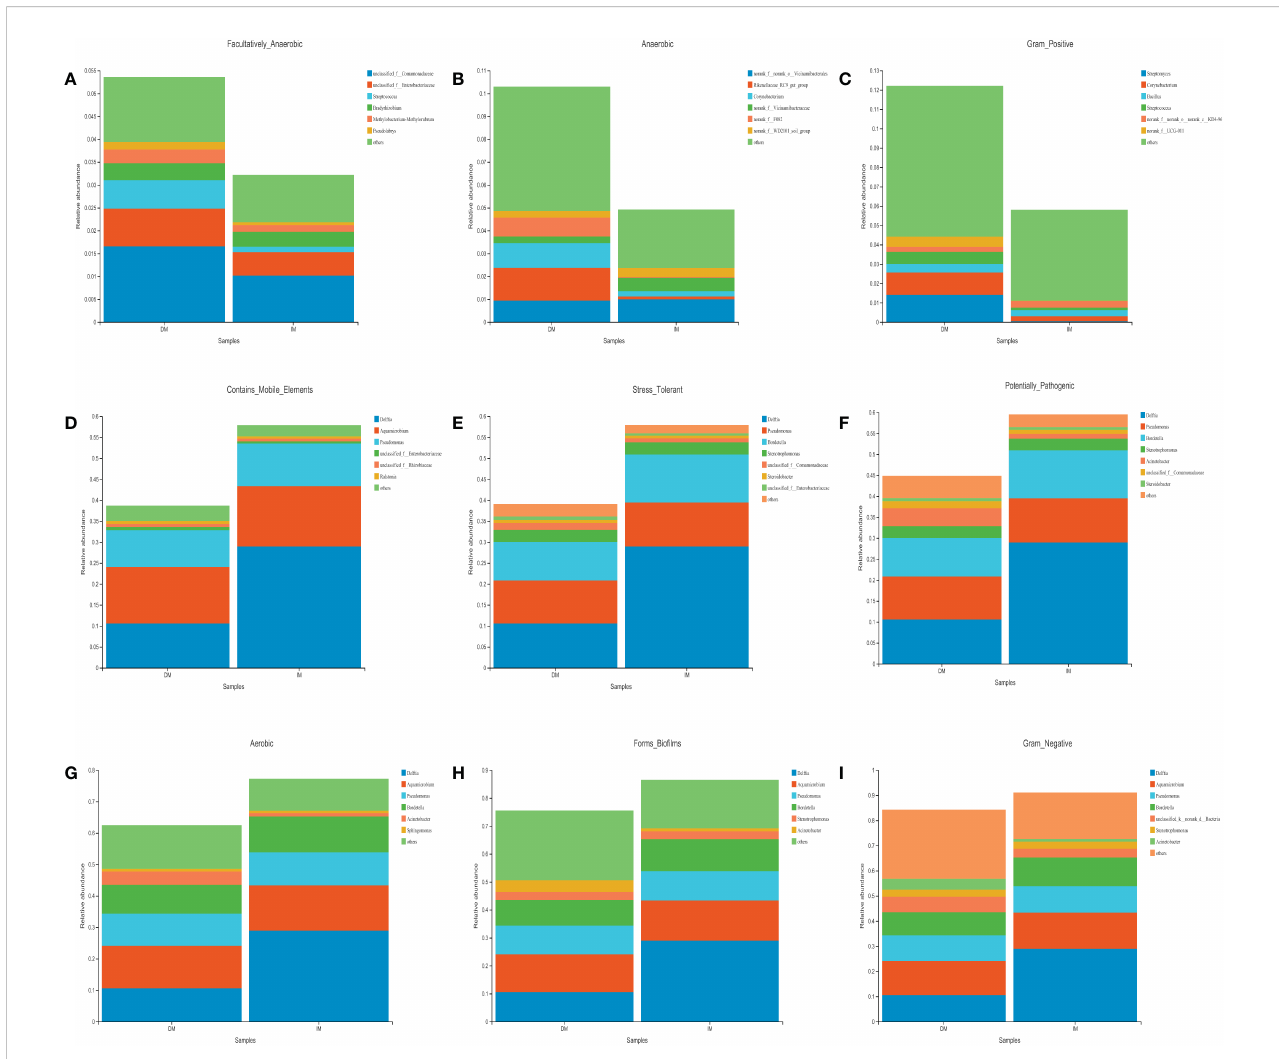
FIGURE 6 The analysis of intestinal species contribution to the phenotypic correlation in both groups. (A) Facultatively_Anaerobic. (B) Anaerobic. (C) Gram_Positive. (D) Contains_Mobile_Elements. (E) Stress_Tolerant. (F) Potentially_Pathogenic. (G) Aerobic. (H) Forms_Bio fi lms. (I)